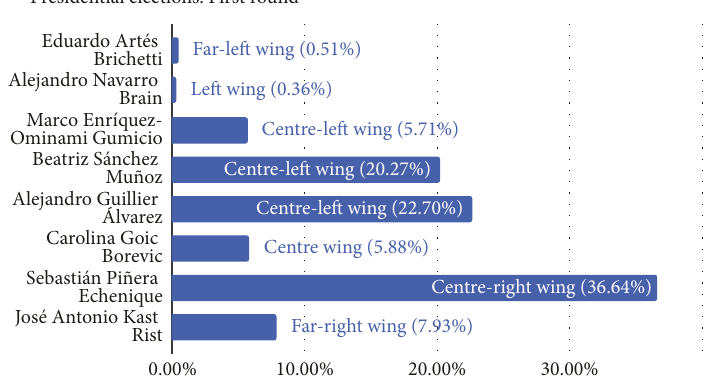
Figure 1: First round results of the 2017 Chilean Presidential elections.